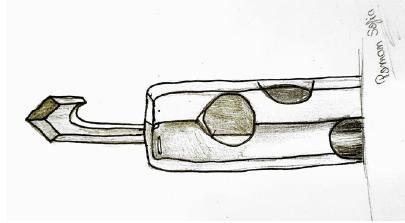
Figure 7. Dedicated extraction hook.